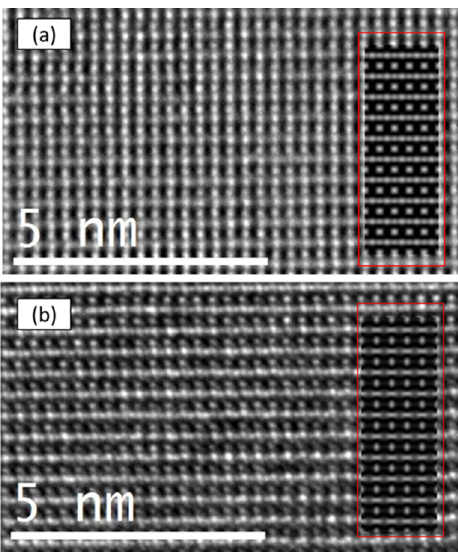
Figure 5. HRTEM images of the samples made by ( a ) wedge polishing and ( b ) FIB along the [110] zone axis. The red rectangles contain an overlap of the result of an image simulation on BaTiO 3 ; the thickness of the sample is 24 nm and the defocusing was set to 40 nm and 50 nm, respectively.